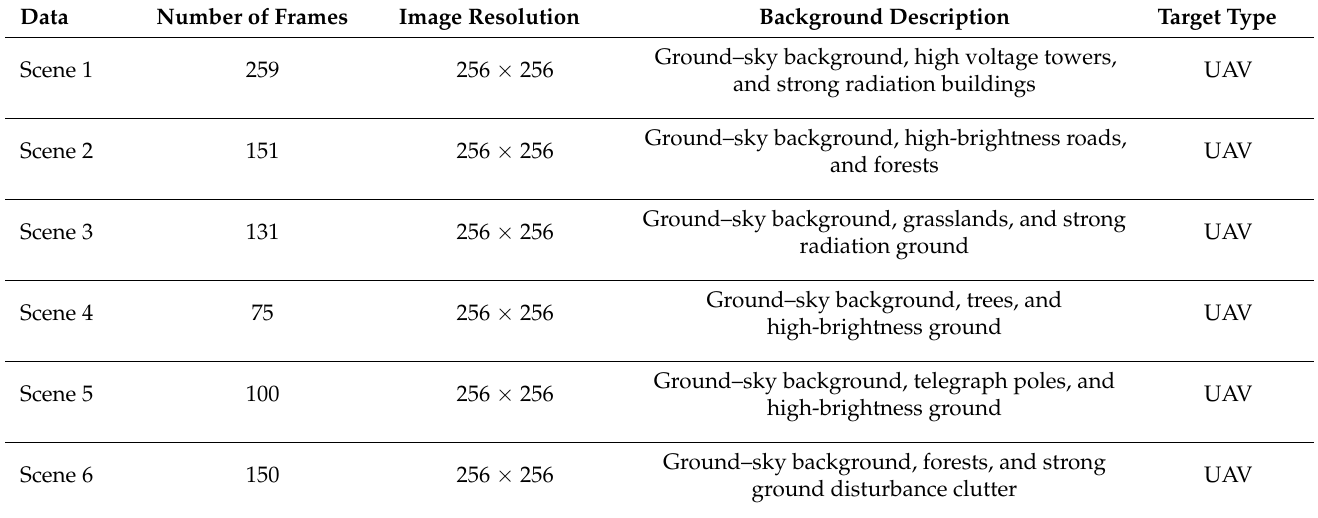
Table 1. Details of the six test